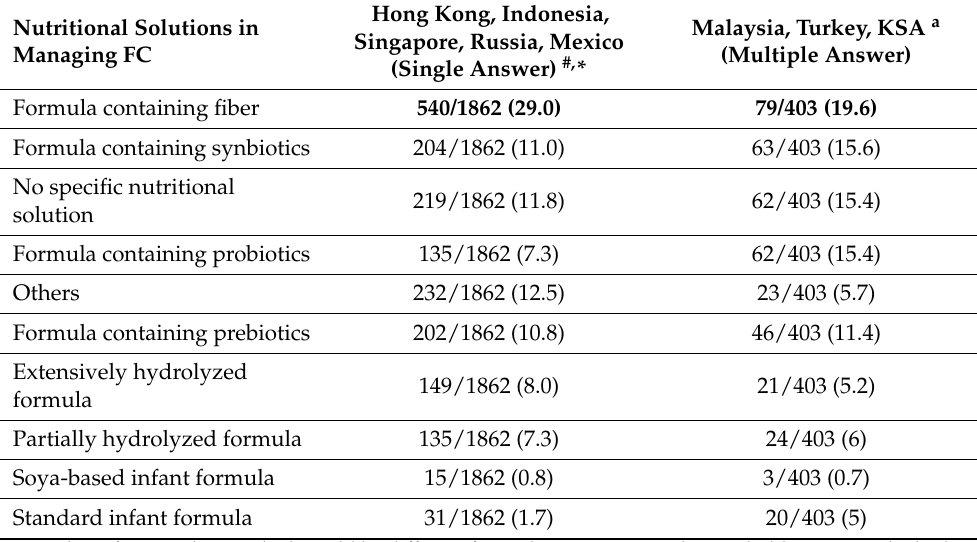
Table 2. The specific nutrition solutions the HCPs often use in managing FC in